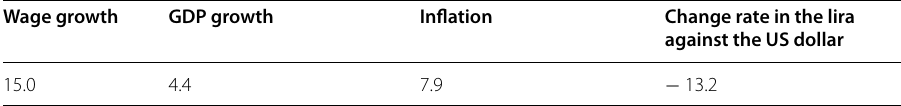
Table 7 Macroeconomic factors of Turkey (annual rate, unit: %, 2011–2015). Source : GDP growth, wage growth (compensation of employees, current LCU) and inflation (consumer price) were derived from the World Bank. Exchange rate is from OECD